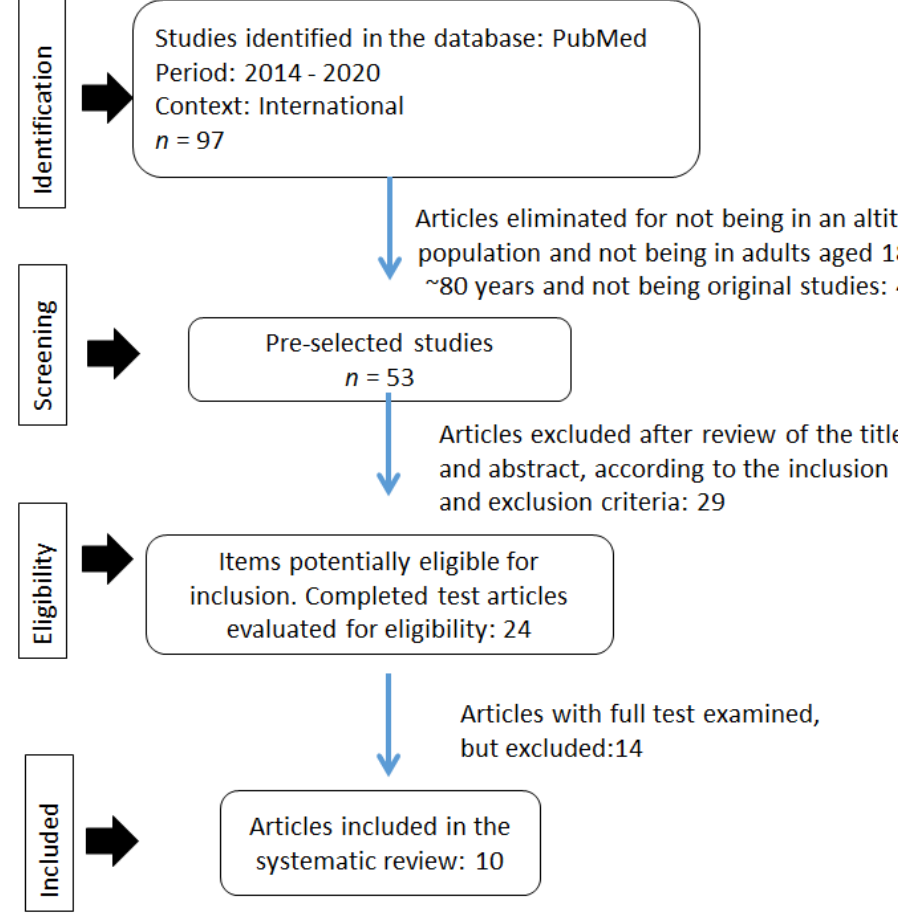
Figure 1. PRISMA flow chart for the systematization of original articles 2014–2020.